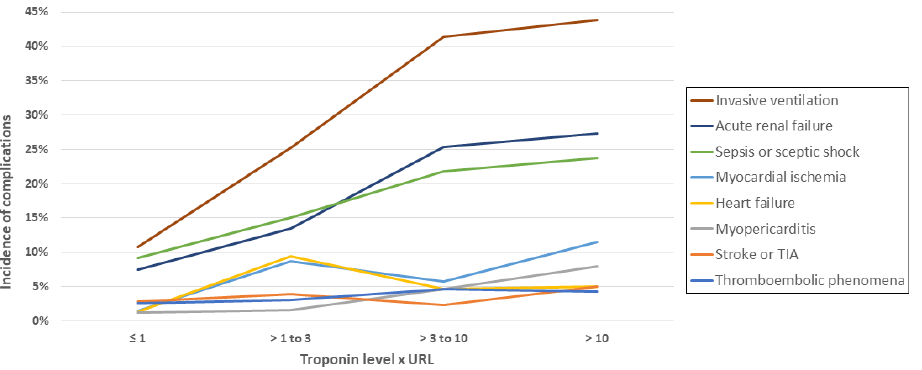
Figure 4. Incidence of in-hospital complications according to troponin level ( n = 1476). TIA, transient ischemic attack; URL, upper reference limit.